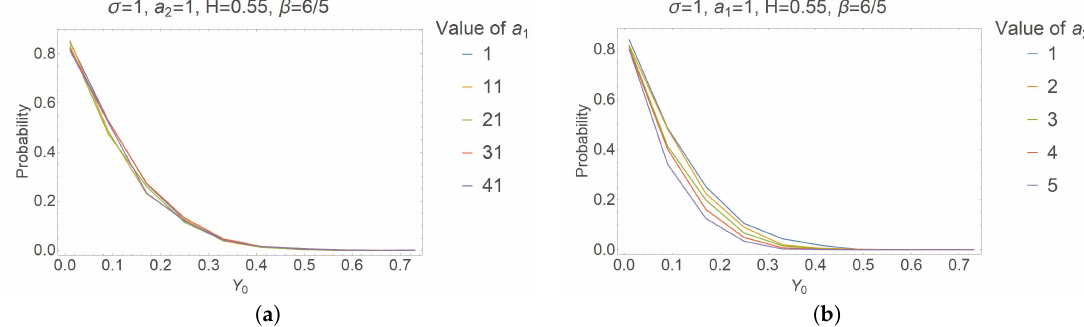
Figure 4. Probability that the trajectories have negative values: ( a ) Dependence of probability on a 1 . ( b ) Dependence of probability on a 2